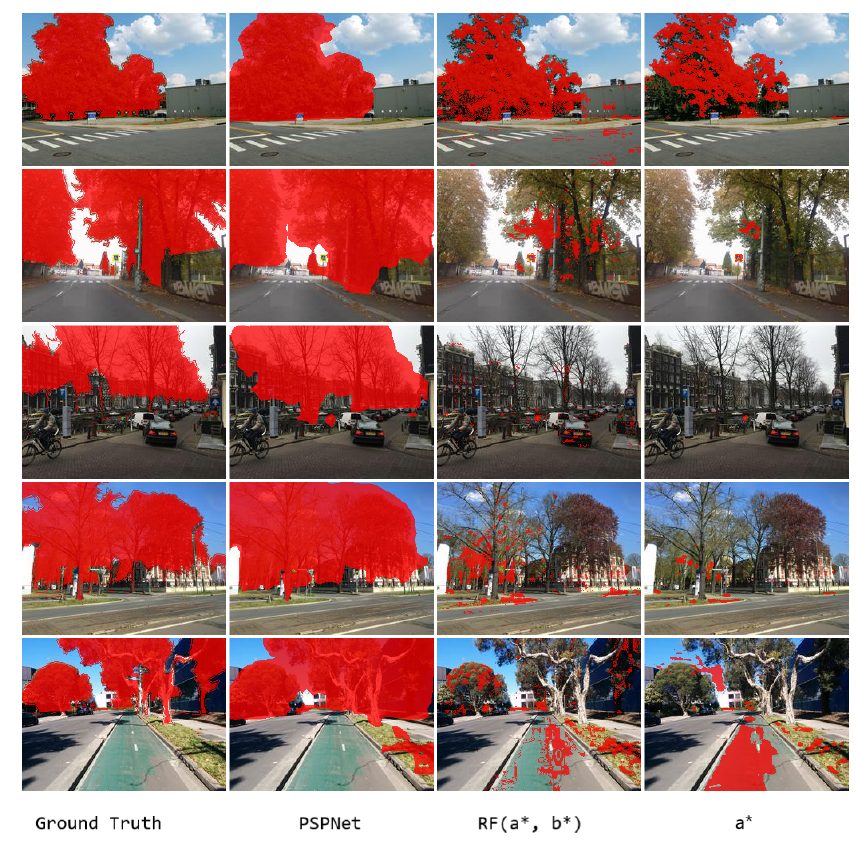
Figure 7. Illustration of competing vegetation segmentation approaches. Every column corresponds to the manually annotated output and our three competing approaches. Every row corresponds to a scene illustrating different types of challenges, respectively: “clearcut” segmentation of vegetation; vegetation in autumn where green leaves are not present; vegetation in winter with no leaves; vegetation with no green leaves; and vegetation with lane painted in green. Pixels labelled as vegetation are highlighted in